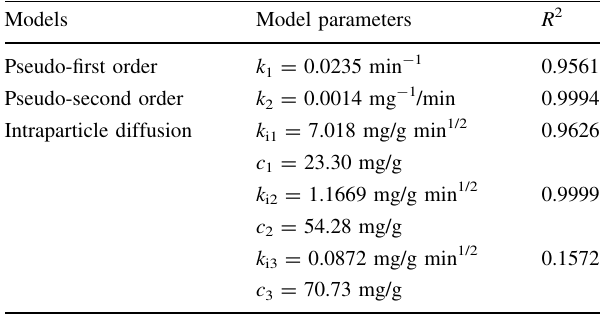
Table 3 Kinetic models for AM adsorption on AC-PEI at 298 K